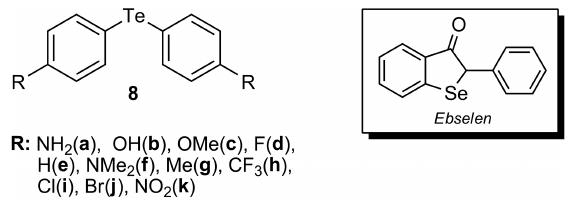
Fig. 4 – Arylic tellurides used in the first demonstration of their GPx-like activity.